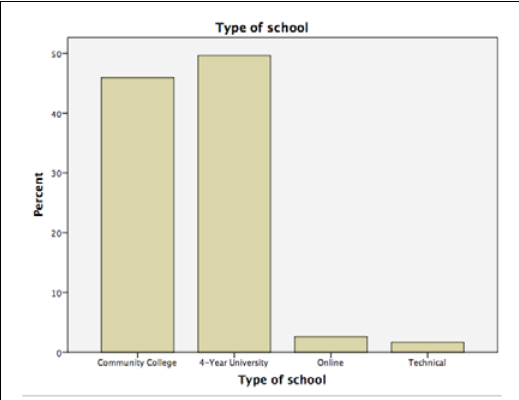
Figure 1: Age distribution of surveyed students